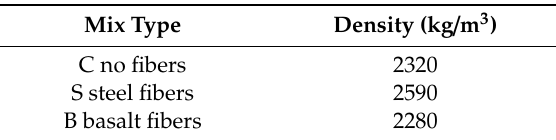
Table 4. RPC density (kg / m 3